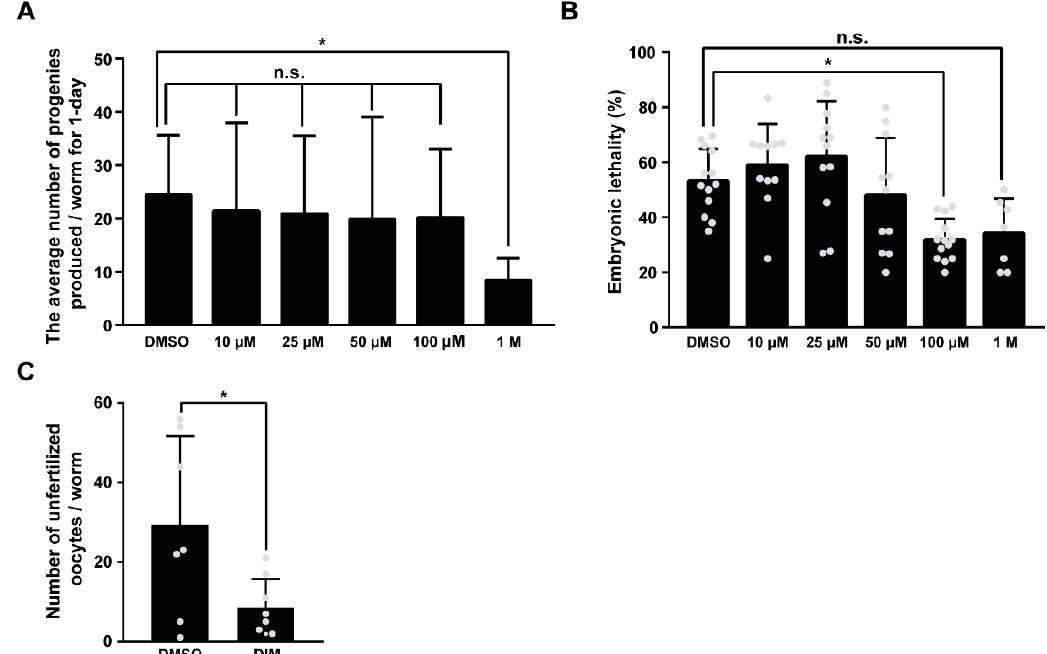
Figure 2. DIM supplementation improved the reproductive capacity in reproductively aged Caenorhabditis elegans : ( A ) The graph indicates the number of total embryos in wild ‐ type N2 supplemented with DMSO or DIM (10, 25, 50, 100 μ M, and 1 M concentrations) at the day 3 adult stage for 24 h. Error bars represent SD. n.s., not significant., *, p < 0.05 (one ‐ way ANOVA with Turkey post ‐ hoc test). Each condition, n > 8. ( B ) The graph indicates the percentages of unhatched embryos per total embryos in wild ‐ type N2 supplemented with DMSO or DIM (10, 25, 50, 100 μ M, and 1 M concentrations) at the day 3 adult stage for 24 h. Error bars represent SD. n.s., not significant., *, p < 0.05 (one ‐ way ANOVA with Turkey post ‐ hoc test). Each condition, n > 8. ( C ) The graph indicates the number of unfertilized oocytes produced from day 4 adult wild ‐ type N2 worms supplemented with DMSO or DIM. Error bars represent SD. *, p < 0.05 (multiple t ‐ tests).